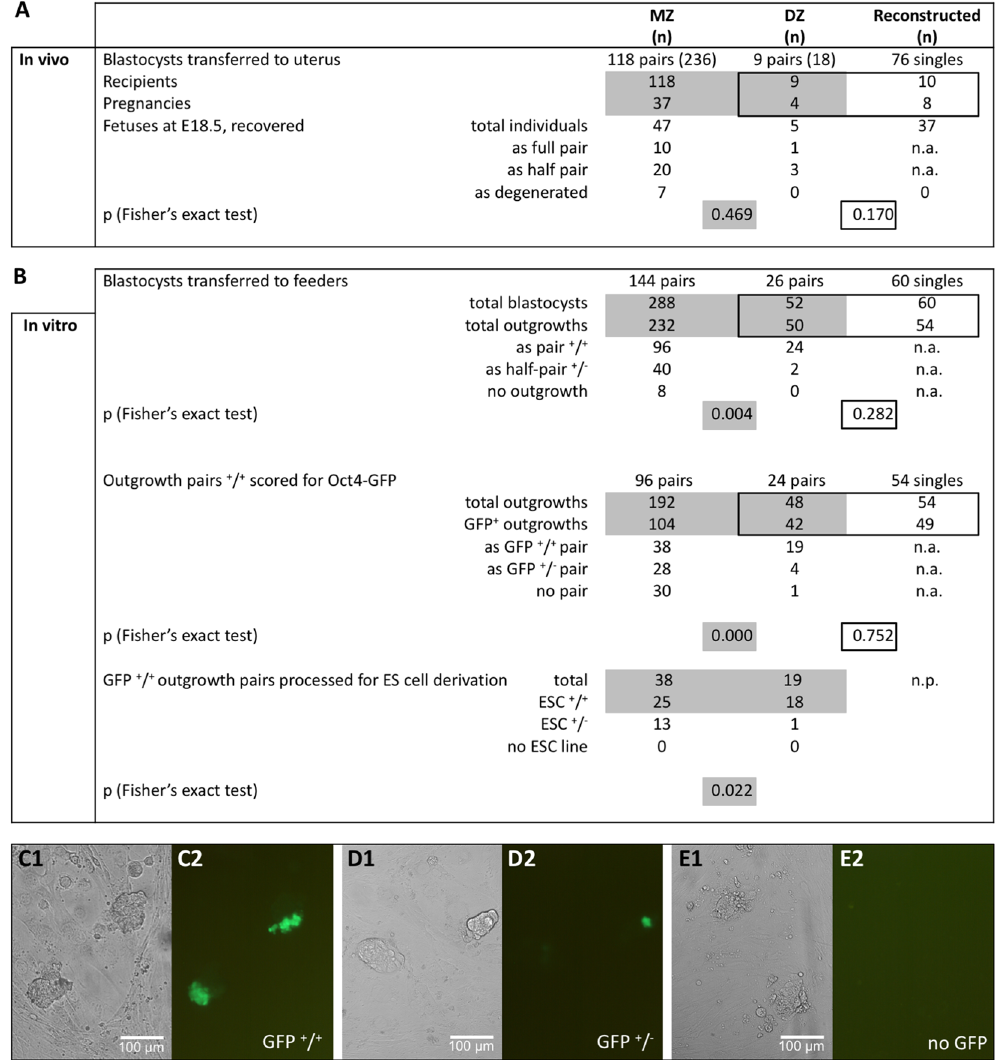
Figure 2. Functional analysis of MZ twin pairs. Single pairs of MZ twin blastocysts were transferred to the uteri of pseudopregnant recipients (one pair per recipient), using DZ twins and reconstructed embryos (separated- reunited blastomeres) as controls ( A ). Single pairs of MZ twin blastocysts were transferred to a layer of feeder cells to enable outgrowth formation and ES cell derivation ( B ). Statistical comparisons were conducted on the pairs of MZ and DZ twins, and on the individual embryos of DZ twins and separated-reunited blastomeres (Fisher’s exact test). Gray-shaded areas visualize the comparison of MZ and DZ twins with each other; black- framed areas visualize the comparison of DZ twins and reconstructed controls with each other. n.a., not applicable. n.p., not performed. The functional status of the outgrowths was validated by scoring the expression of Oct4-GFP ( C–E ; “1” refers to light microscopy, “2” to fluorescence